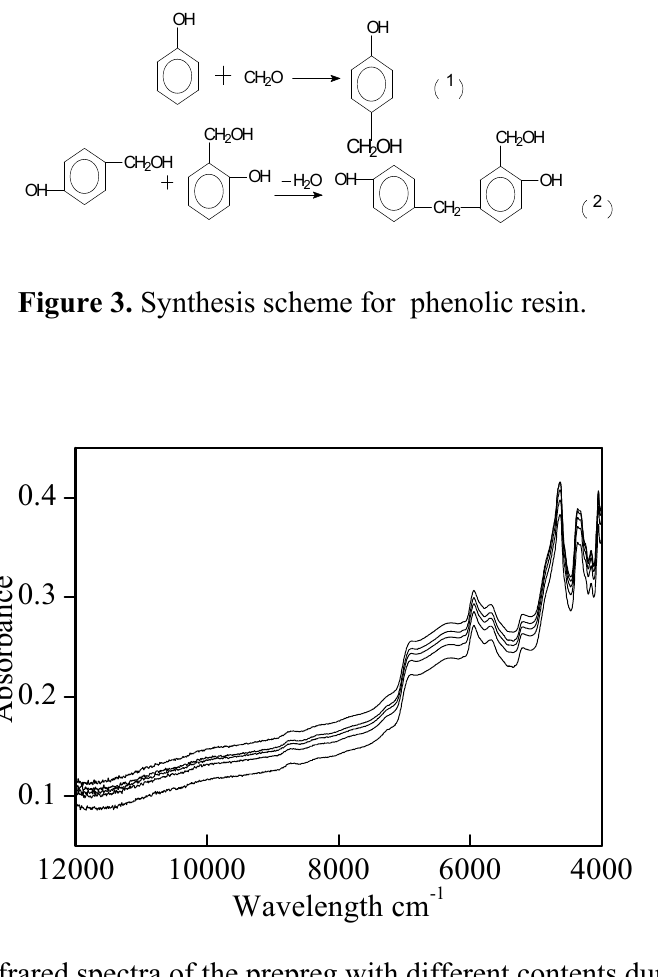
Table 1a. Statistical parameter of calibration set for quality indexes of the